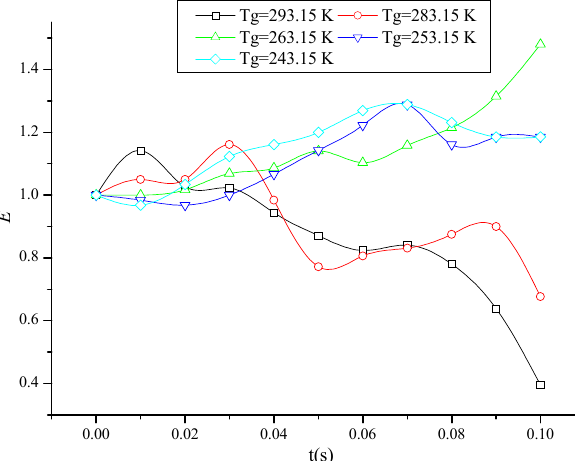
Figure 4. Variation in water drop deformation ratio E .